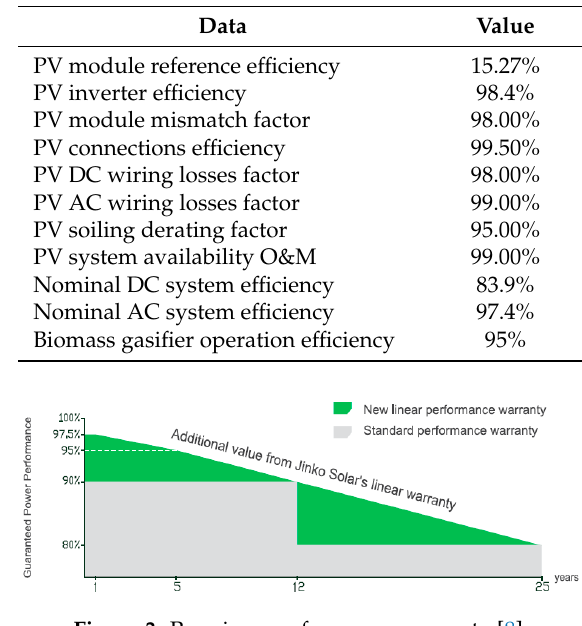
Table 3. Efficiency and performance variables. Table 3. E ffi ciency and performance variables.